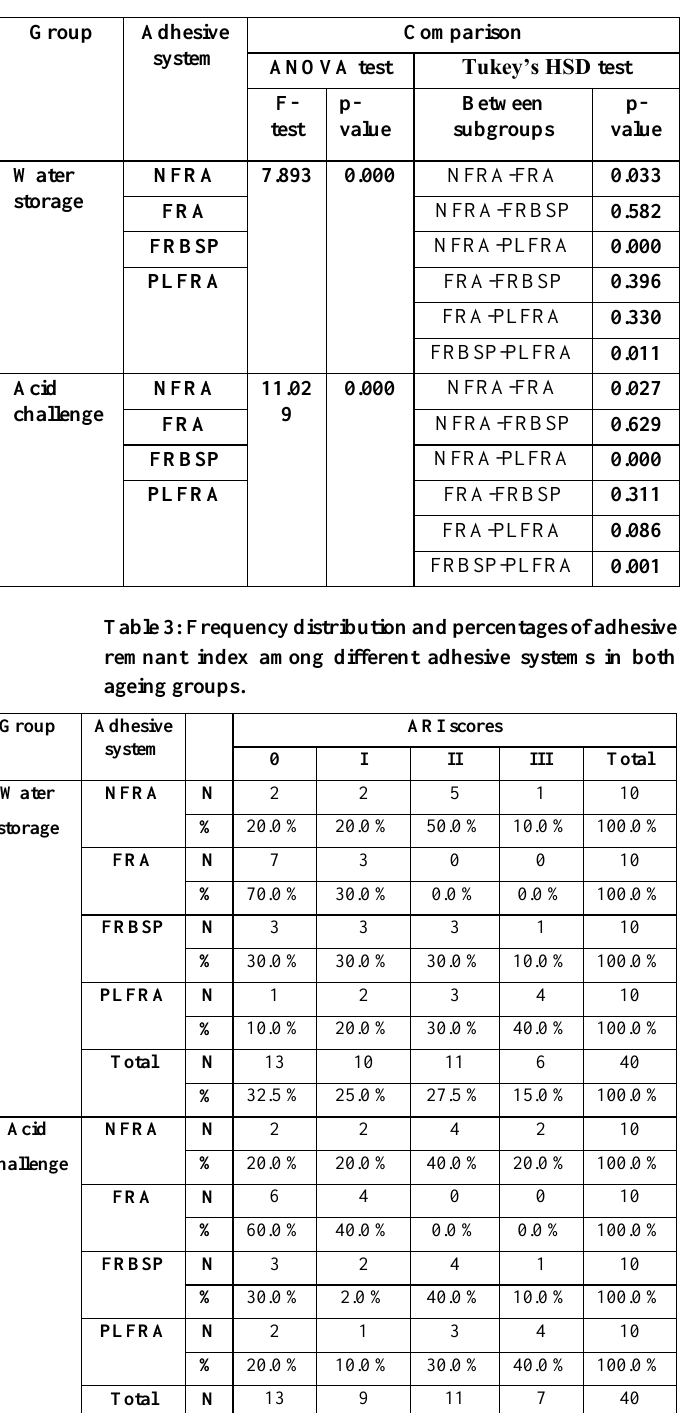
Table 2: Comparison of the mean shear bond strength test in different groups by ANOVA and Post-hoc Tukey’s HSD test.